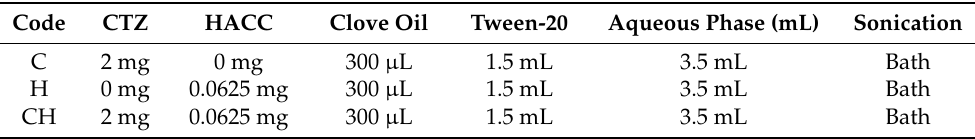
Table 2. Three sets of microemulsion compositions.